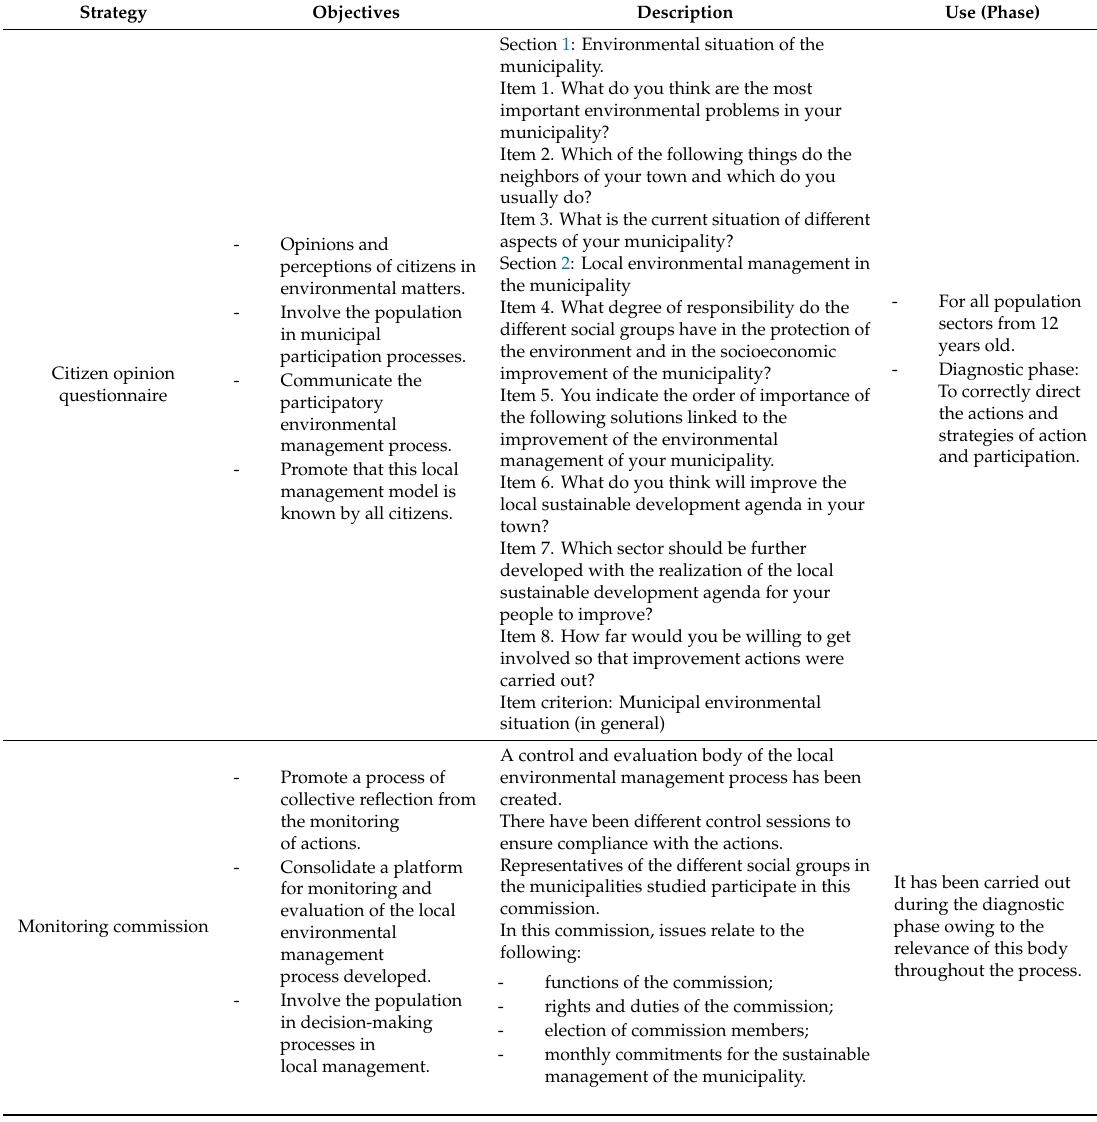
Table 2. Information collection